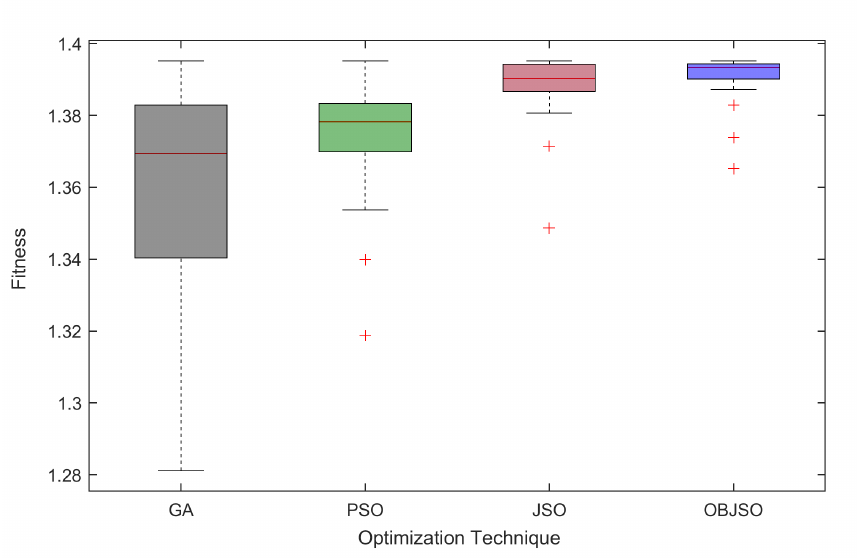
Figure 5. A performance comparison in terms of fitness.